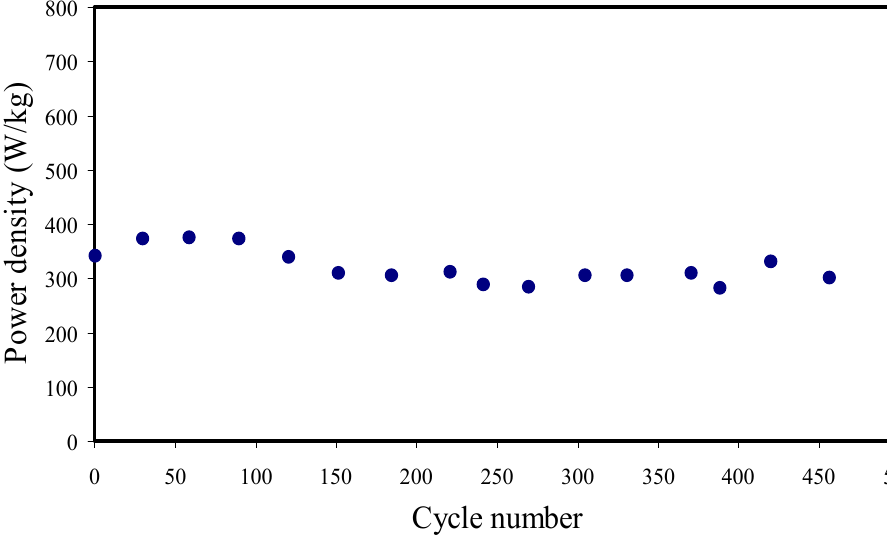
Figure 15. Power density of the EDLC device for the 450 cycles at RT. Table 6. EDLC parameters using different polymer electrolytes at RT.